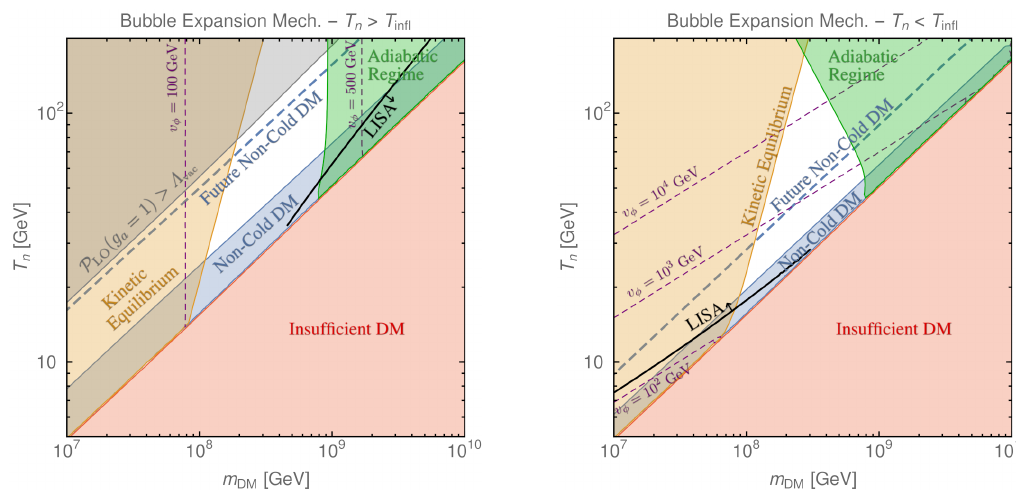
Figure 2: Heavy non-cold DM from fast bubble walls in the plane of nucleation > T < T temperature T vs DM mass m , for T (left) and T (right). We n n n infl infl DM = 10 − 2 . Viable non-cold DM can be produced in the range set λ = 1 and c vac ≈ 10 8 − 10 9 GeV (white area), delimited by: the requirement of the anti- m DM = 3 and β = 10 (green); too adiabatic regime, Eq. (8), at bubble collision with A H bub = T small DM yield, Eq. (9), even with the DM number maximizing choice T n infl (red); kinetic equilibration, i.e. violation of Eq. (11) (tan); the bubbles not run- < ning away, i.e. Λ of Eq. (4) (gray, left); the warm DM velocity limit for vac P LO ≳ 5 keV, corresponding to v ( t ) ≲ 5 × 10 − 5 (blue). The blue NCDM region m eq WDM ≈ 5 − 7 (left) and v / T ≈ 7 − 12 (right). The dashed blue line shows spans v φ / T φ n n = 15 keV, v ( t ) ≈ 10 − 5 . Purple dashed contours show the future sensitivity at m eq WDM the VEV, v φ . The region below (above) the black contour on the left (right) panel can be tested by LISA with a signal-to-noise ratio SNR > 5. In the left panel, however, this lies outside the valid domain of parameter space for the DM